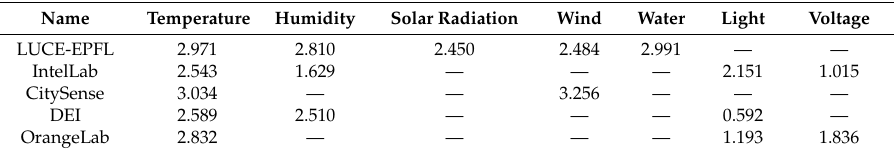
Figure 2. Spatial compressibility of CitySense temperature. Table 2. Analysis of the marginal entropy (in bits) of different datasets in